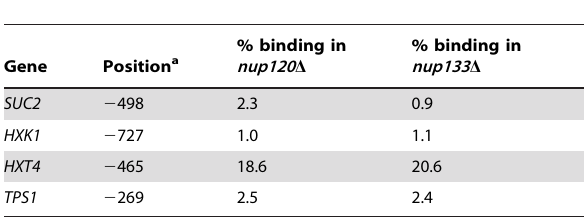
Table 3. Binding of Mig1 to glucose-repressed promoters.